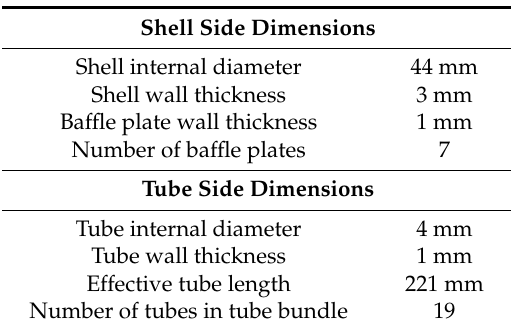
Figure 5. Separated fluid zones on the shell side of the heat exchanger. In numerical calculations, mesh generation is very crucial for getting accurate predicted results and reducing the computation time [9,12,14,18,19]. The mesh structure of the surfaces of the computational domain and the section view of this domain are shown in Figure 6. Today, there are many computer software packages for flow field and heat transfer analysis. For the mesh generation